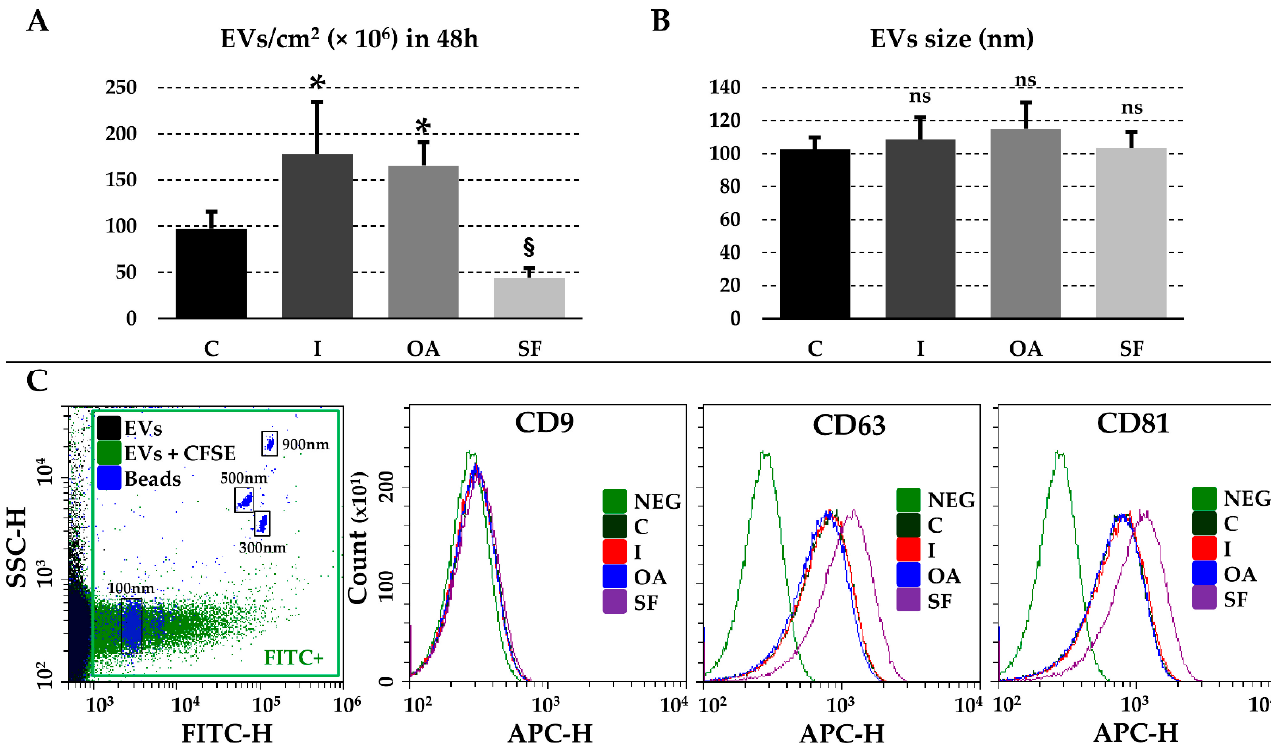
Figure 1. ASC-EV characterization. ( A ) Number of EVs secreted per cm 2 in 48 h. § stands for p -value ≤ 0.1, * for p -value ≤ 0.05, n = 5 for C, I and OA samples, and n = 3 for SF samples, significance calculated vs. C using ANOVA test with Holm multiple comparison. ( B ) Mean particle size analysis from NTA data. ns stands for not significant, n = 3, significance calculated vs. C using Student t-test with significance level set at p -value ≤ 0.05. ( C ) Immunophenotype of released CFSE-labeled EVs after their gating as positive events in the FITC-H channel. FITC-fluorescent nanometric beads of predetermined size (100, 300, 500 and 900 nm) are shown in blue. CD9/63/81 staining is detected in the APC-H channel due to APC-conjugation of the respective antibodies. NEG refers to unstained CFSE-EVs and only the NEG plot for C condition is shown for clarity. One representative donor is